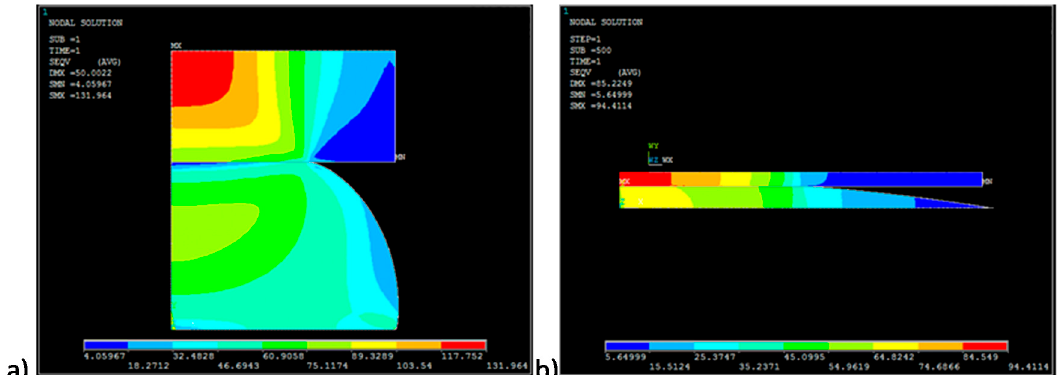
Figure 25. Exemplary distribution of von Mises stress for the contact between the face of the rigid cylinder and the PTFE: ( a ) Hemisphere; ( b ) Spherical cap.